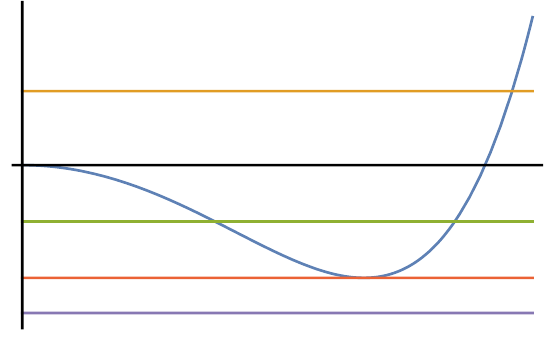
Figure 1 . Rough plot of (3.24). One sees that, as we vary c 2 , we can have 0, 1 or 2 strictly positive